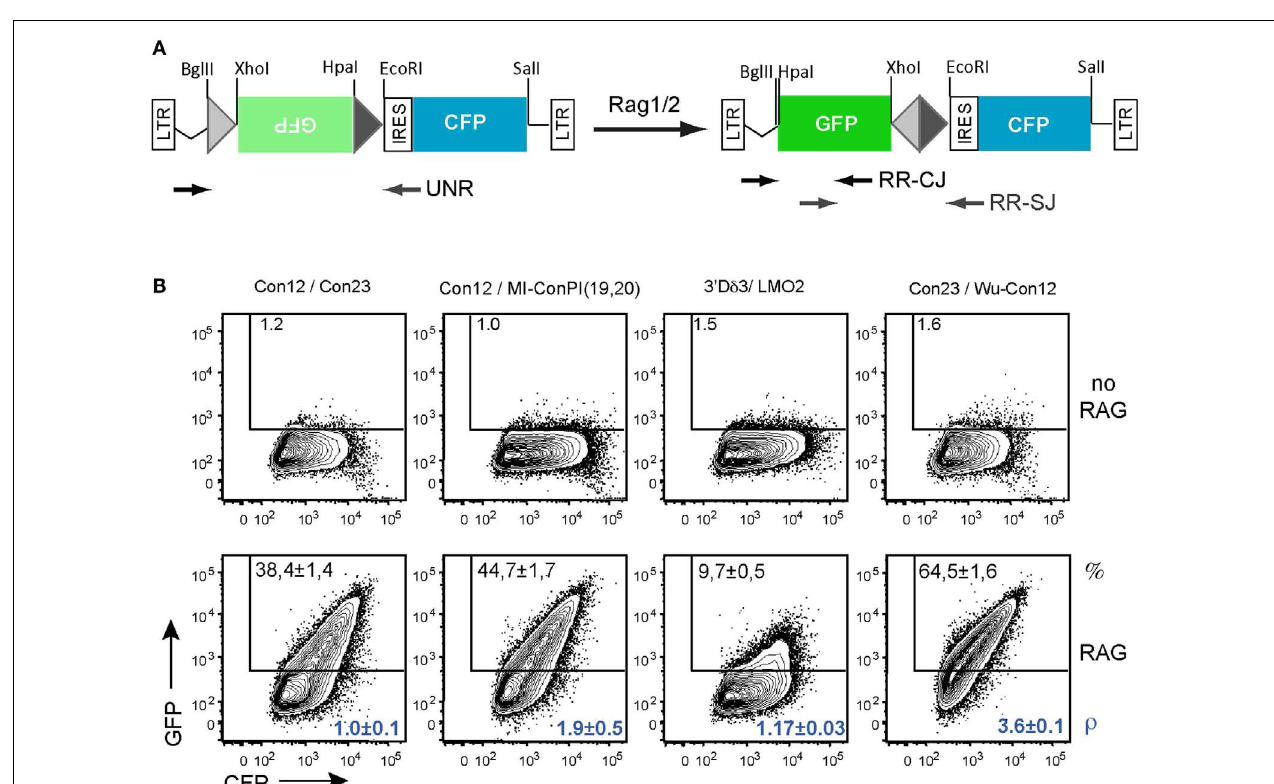
of LMO2 described in Dik et al. (2007).The specific pairs of RSS tested are indicated above the corresponding FACS plots and the sequences listed in Table 2 .The recombination efficiency defined as (% GFP + cells in test -% GFP + cells in control) is indicated in the upper part of each plot.The relative recombination coefficient ρ , when con12/con23 is 1, is indicated in the bottom part of each plot, in blue. four replicates of two independent